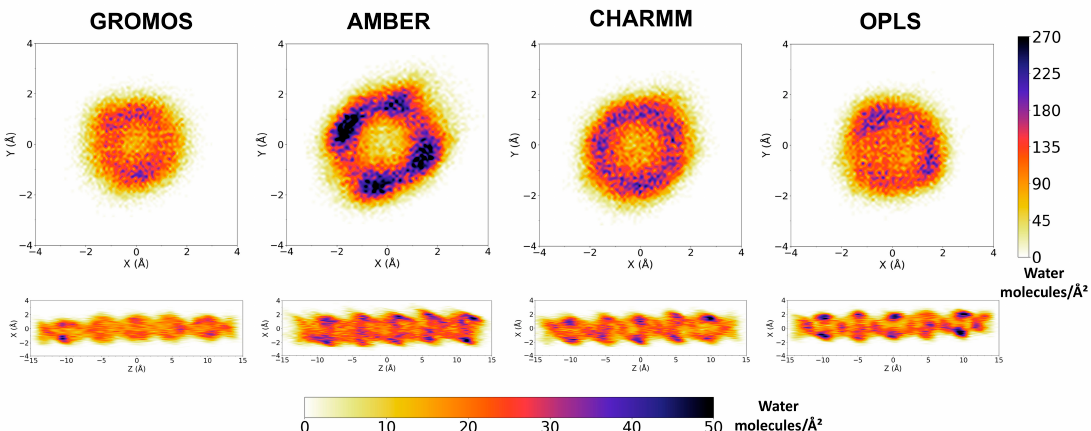
Figure 9. Two-dimensional positional probability distributions of water molecules determined along the last 220 ns of the trajectories, represented as an orange–blue color gradient for the force fields indicated in the labels. Only the region corresponding to the 6 inner CPs is considered for this analysis. Analogous profiles corresponding to the GROMOS-modified force fields are represented in Figures S7 and S8. Note that the longitudinal perspective (in the XZ plane) represents the projec- tion in two Cartesian dimensions of the density of water molecules contained in a cylinder-shaped volume; thus, the middle area of the image (around X = 0) is affected by the low-density central region of the channel, while the edges of the projection only have the contribution of the cylinder contour.